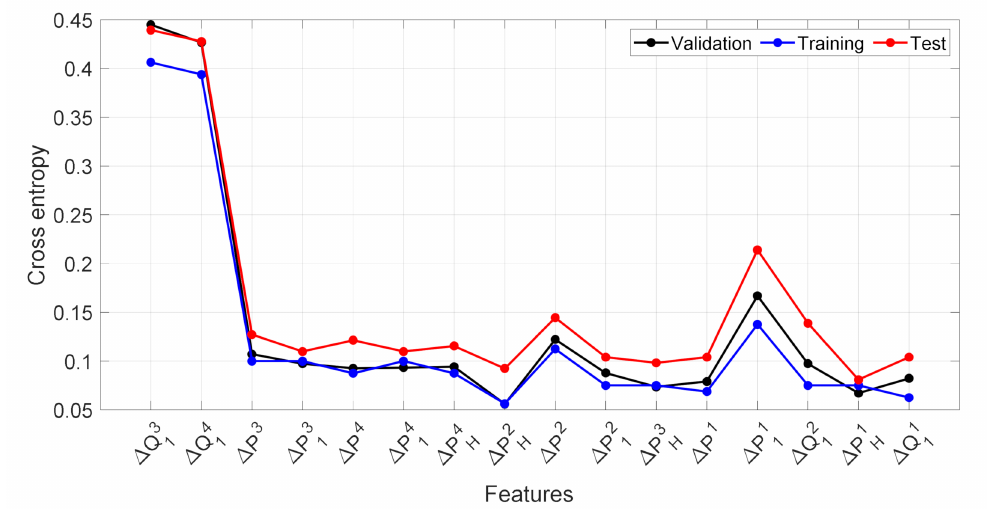
Figure 7. Training, Validation and Test sets error for different number of input features. The horizontal axis shows the features added to the MLP input for each training session. The superscript identifies the observation window after the event.